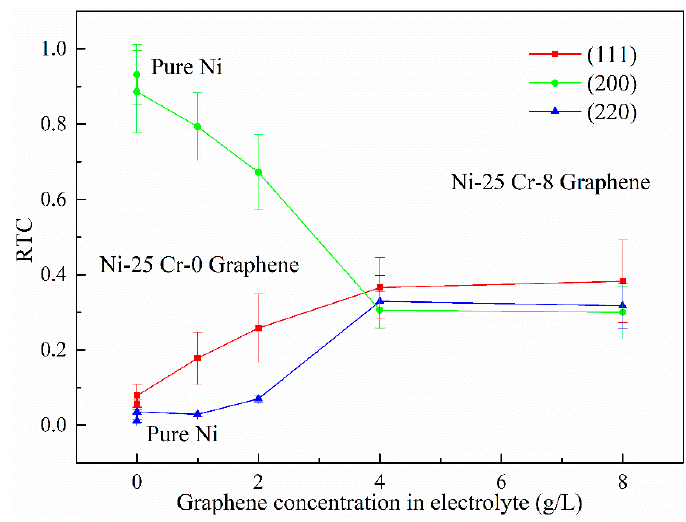
Figure 11. Relative texture coefficient (RTC (hkl) ) values of the Ni–Cr–graphene coatings with respect to graphene concentration in the electrolyte.